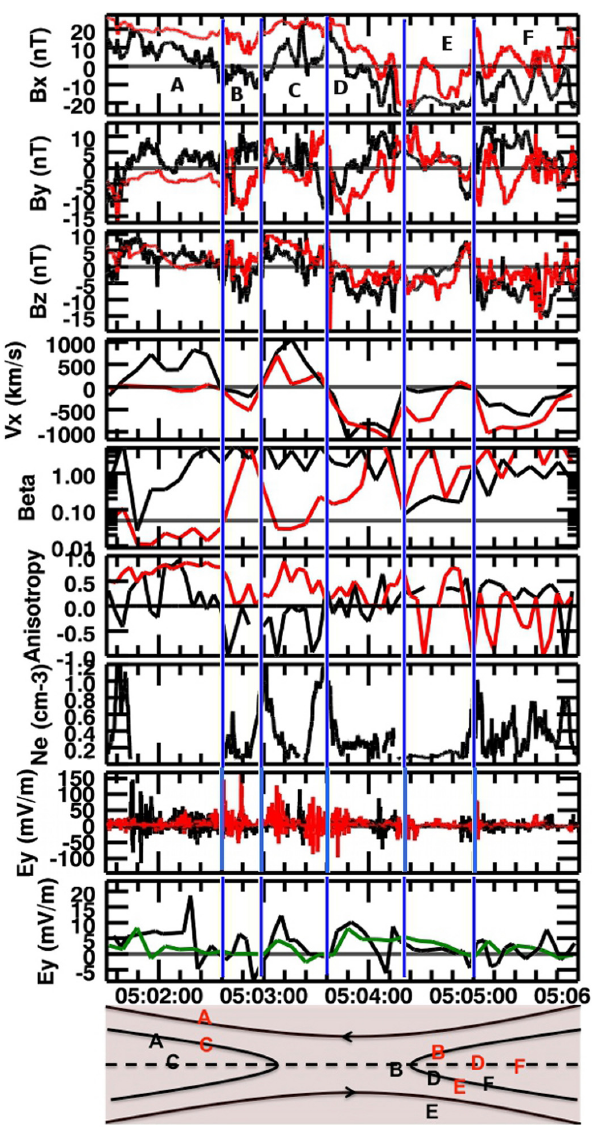
Fig. 2. Example of magnetic reconnection inflow and outflow time intervals observed by Cluster spacecraft 1 (black) and 4 (red) dur- ing the 15 September 2001 ion diffusion region encounter. The plots show (from the top panel): the magnetic field X, Y and Z compo- nents, the ion velocity X component, the plasma beta, the anisotropy − perpendicularflux ( alignedflux ), the electron density derived from the alignedflux + perpendicularflux spacecraft potential (Pedersen et al., 2008) (only the spacecraft 1 potential was within the criteria defined in Pedersen et al. (2008)), the electric field Y component (0.02s resolution) and in the bottom panel: The SC1 electric field Y component (black, 4s resolution) and SC1 ( − v i × B) y (green). The observations have been divided into intervals A–F, identified as inflow/outflow intervals in the text. The bottom panel shows a rough sketch of the positions of space- craft 1 (black letters) and spacecraft 4 (red letters) inside the ion diffusion region during intervals A–F (not to